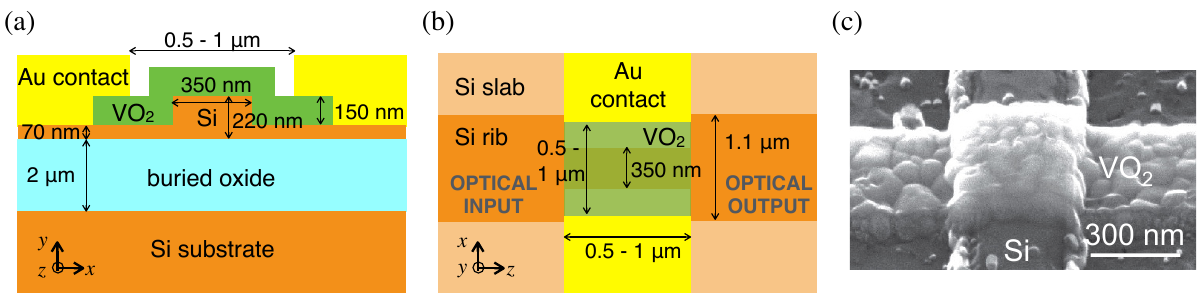
Figure 1. ( a ) The cross-section and ( b ) top views of the wavelength-sized hybrid Si-VO electro-absorption switch and photodetector presented in [11]. ( c ) A scanning electron micrograph of an etched VO strip atop a Si rib waveguide. This would form the 2